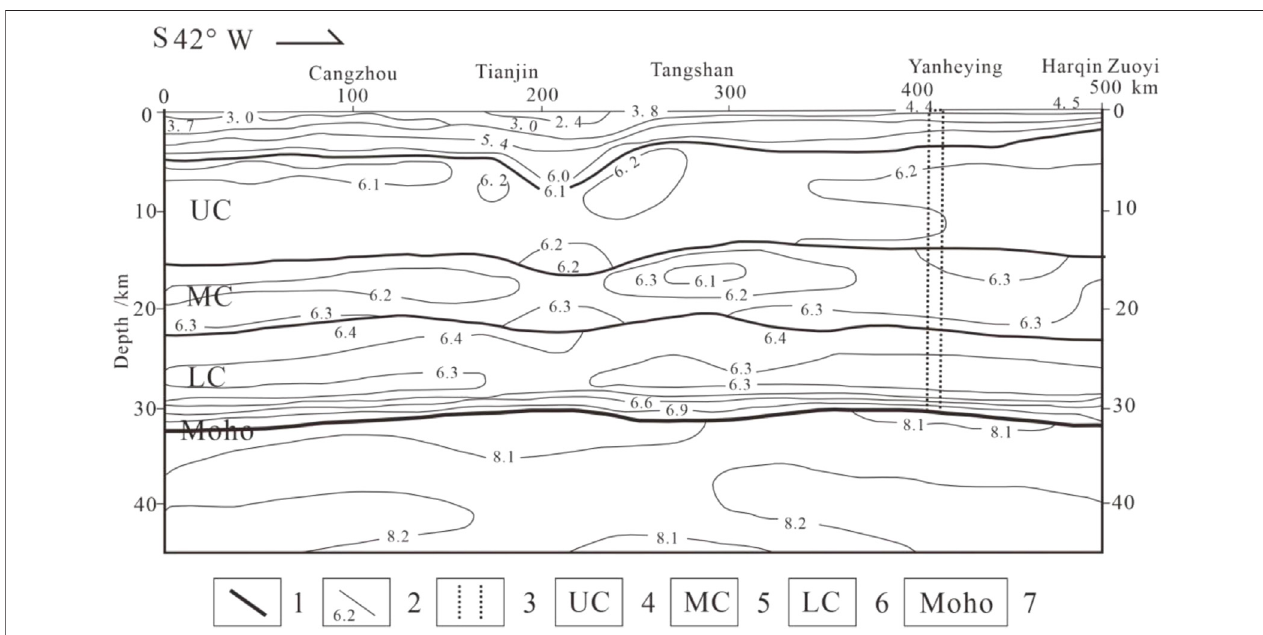
FIGURE3| DistributionofP-wavevelocityinthegeologicaltransectfromCangzhoutoHarqinZuoyi(modi fi edfromShaoetal.,1989;thelocationofthesectionline is de fi ned in Figure 1 ).